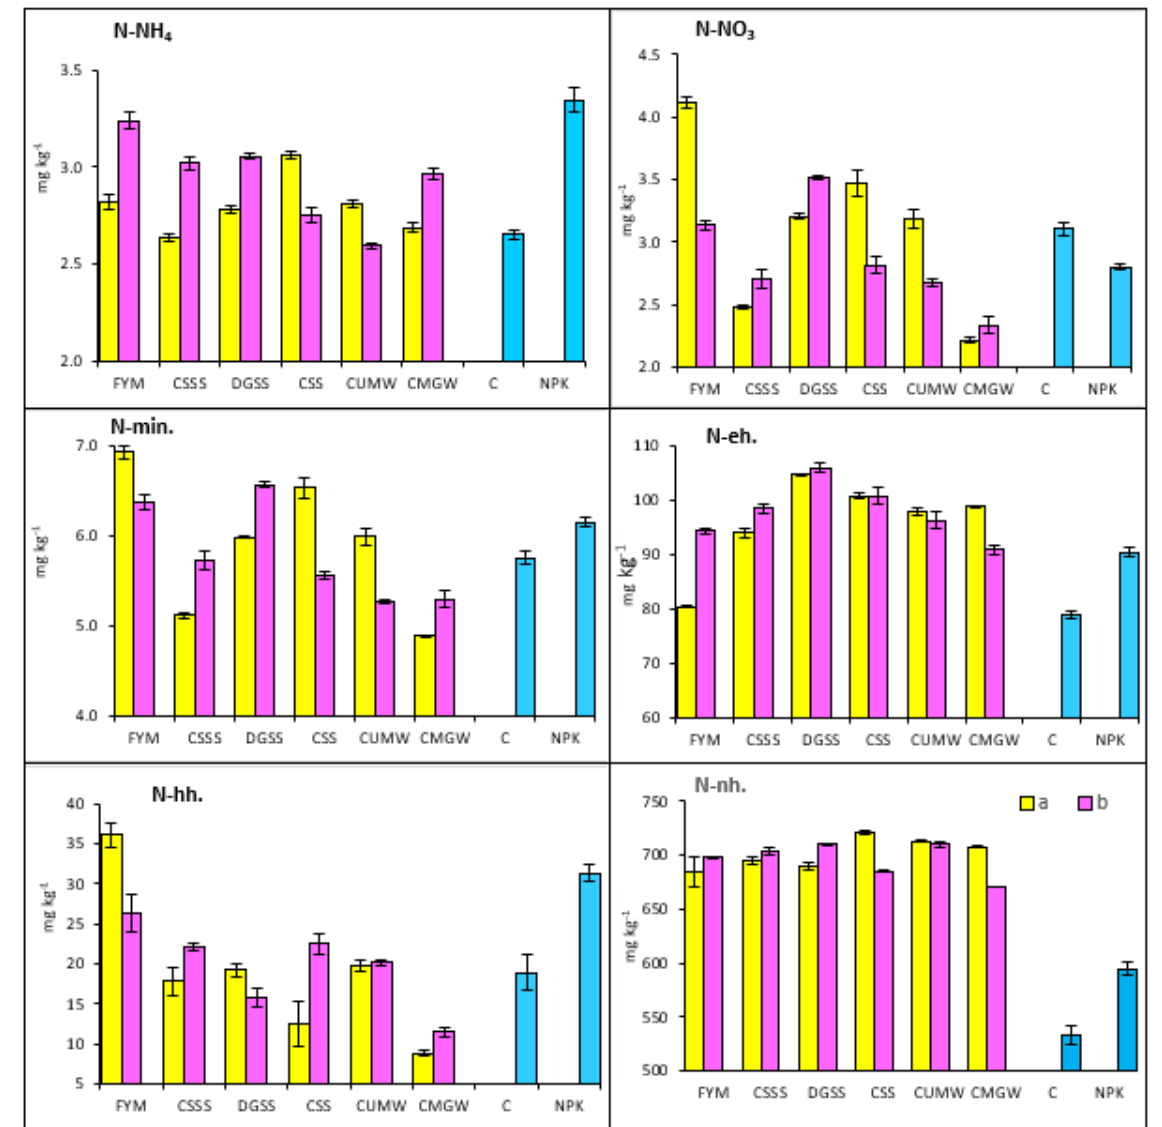
Figure 2. Content of bound N in determined fractions: mean ± SE; N-min.—mineral; N-eh.—easily hydrolysable; N-hh.— hardly hydrolysable; N-nh.—non-hydrolysable (a—2 × 5 t ha − 1 , b—1 × 10 t ha − 1